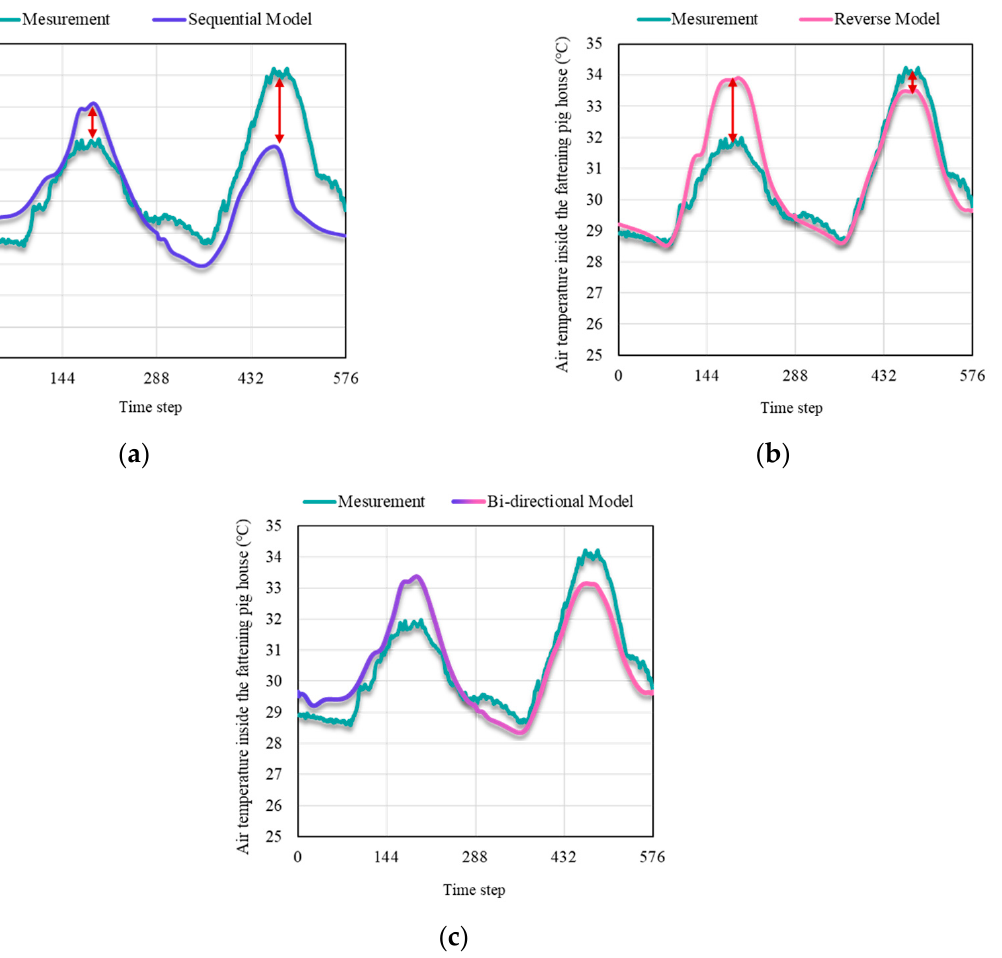
Figure 11. A comparative analysis of the predictive air temperature inside the fattening pig house according to the order of learning data. ( a ) Sequential model. ( b ) Reverse model. ( c ) Bidirectional model.